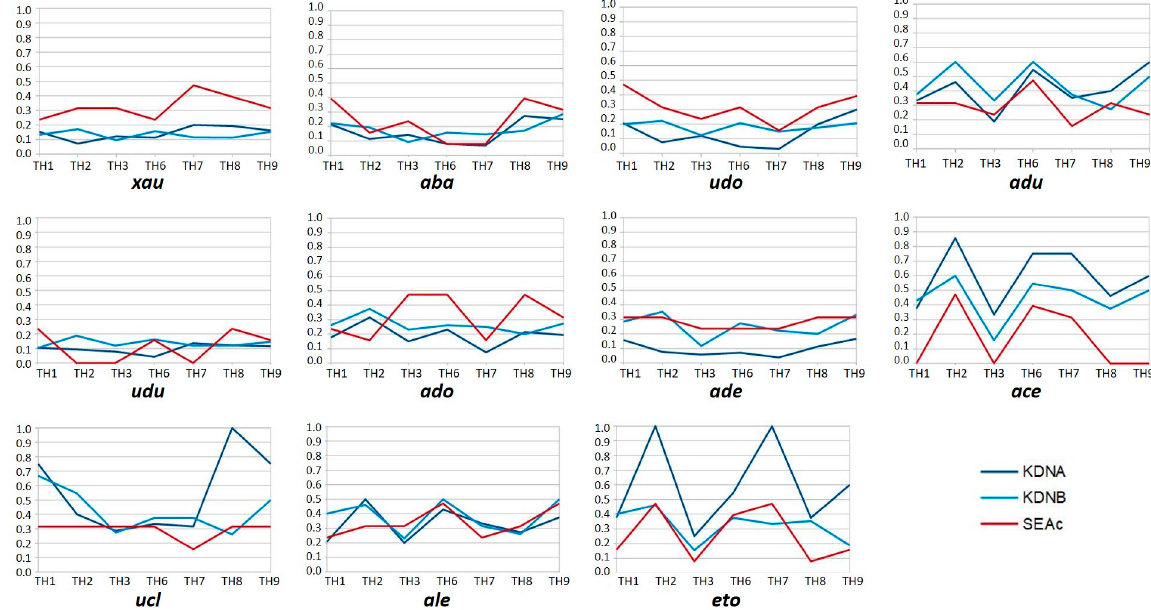
Figure 20. Graphical comparison of the proximities with topic hubs for 11 guests measured through three complementary indicators. KDNA = proximities measured through the guests’ trails. KDNB = proximities measured through the others’ trails. SEAc = self-evaluated proximities.